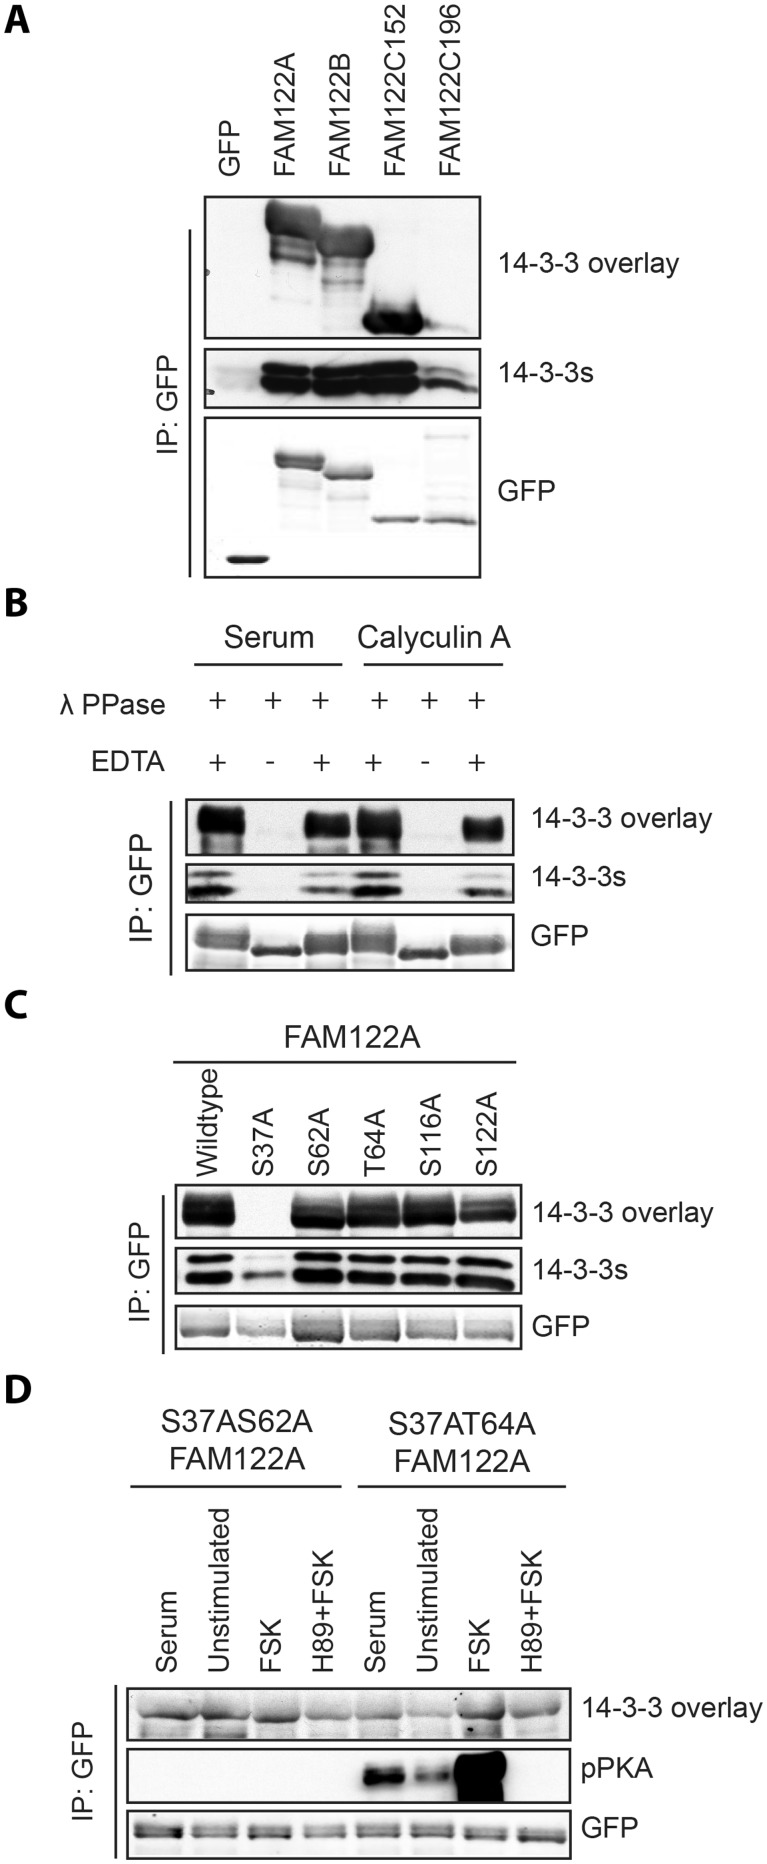
Regulated binding of 14-3-3 proteins to FAM122-GFP proteins. (A) HEK293 cells growing in media containing 10% (v/v) serum were transfected to express FAM122A-GFP, FAM122B-GFP and FAM122C-GFP proteins (the latter as 152 and 196 residue isoforms, respectively, excluding the GFP). GFP-tagged proteins isolated from cell lysates (120 mg) with GFP-Trap® were tested for their ability to bind directly to 14-3-3s in Far-Western assays (overlay) and by coimmunoprecipitation of endogenous 14-3-3s (14-3-3s) using the K19 pan-14-3-3 antibody. Anti-GFP signals show levels of the tagged proteins in the immunoprecipitates. (B) FAM122A-GFP bound to GFPTrap® was dephosphorylated with lambda phosphatase or not when the phosphatase was inhibited with EDTA. The immunoprecipitates were washed and FAM122A-GFP analyzed for its ability to bind directly to 14-3-3s (overlay) and for retention of co-purified endogenous 14-3-3 proteins (14-3-3s). Cells had been grown in standard medium (serum), with 100 nM calyculin A (a protein phosphatase inhibitor) added for approximately 5 min before lysis, as indicated. (C) Wild-type FAM122A-GFP and the indicated serine/threonine-to-alanine mutant proteins were isolated from transfected cells and tested for direct binding to 14-3-3s and for co-immunoprecipitating endogenous 14-3-3s. (D) HEK293 cells were transfected to express Ser37Ala/Ser62Ala- FAM122A-GFP and Ser37Ala/Thr64Ala-FAM122A-GFP, as indicated. Cells were serum starved for 10 h, then stimulated with serum (10% (v/v) for 30 min) or forskolin (20 µM for 30 min) with or without H89 pre-treatment (30 µM for 30 min), as indicated. Proteins immunoprecipitated from lysates were tested for 14-3-3 binding (overlay) and coimmunoprecipitation of endogenous 14-3-3 (14-3-3)